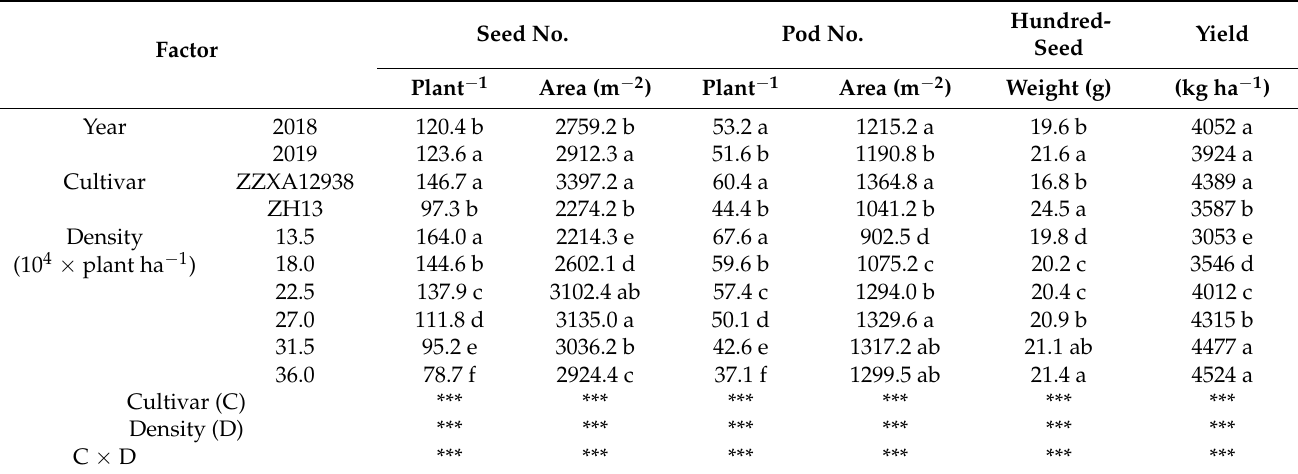
Hundred- Yield Seed